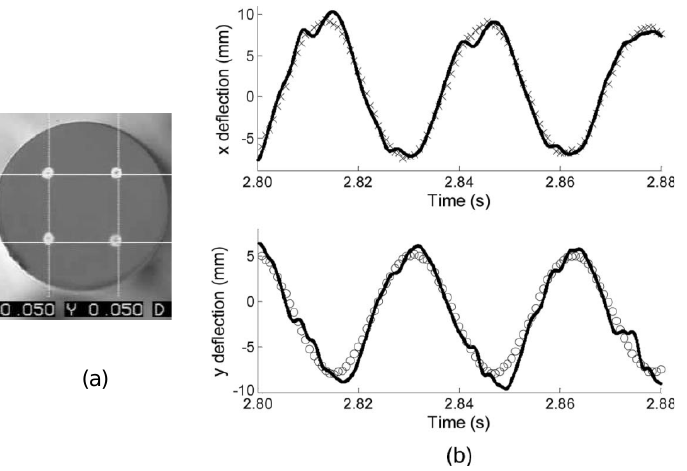
Figure 15. ( a ) Cross-section of the MCF. ( b ) Upper plot, x-deflection measured by MCF FBGs (solid curve) and camera (x). Lower plot, y-deflection measured by sensor (solid curve) and camera (o). Adapted with permission from Ref. [47] © Optica Publishing Group.